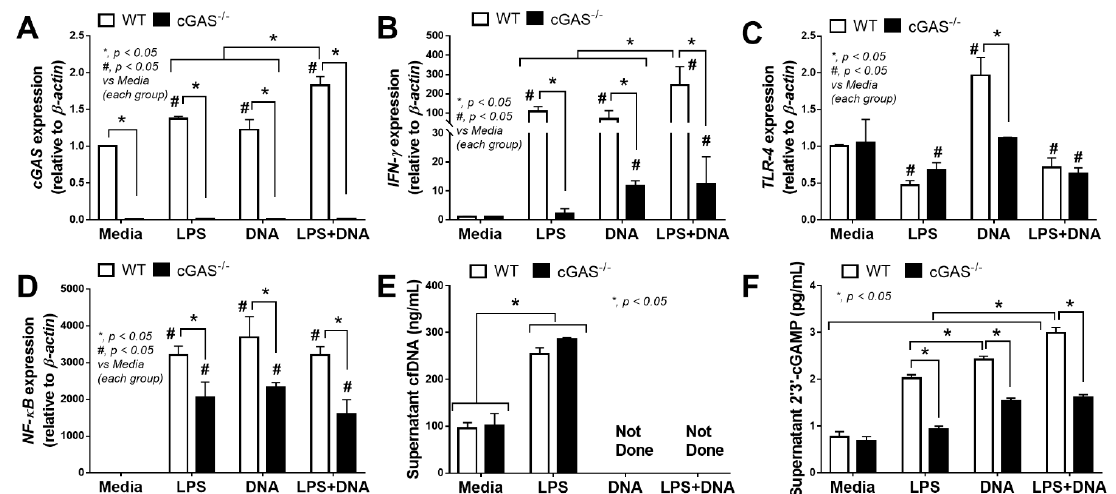
Figure 5. Characteristics of macrophages from wildtype (WT) and cyclic GMP–AMP synthase deficient (cGAS -/- ) mice after an activation by media control, lipopolysaccharide (LPS), bacterial DNA (DNA) and LPS with DNA (LPS+DNA), as indicated by the expression of cGAS ( A ), IFN- γ ( B ), TLR-4 ( C ), NF- κ B ( D ), supernatant cell free DNA (cfDNA) ( E ) and supernatant cyclic guanosine monophosphate–adenosine monophosphate (cGAMP) ( F ). Independent triplicated experiments were performed. Notably, cfDNA analysis in the DNA alone and LPS + DNA groups was not performed due to the possible interference of bacterial DNA in cfDNA measurement.